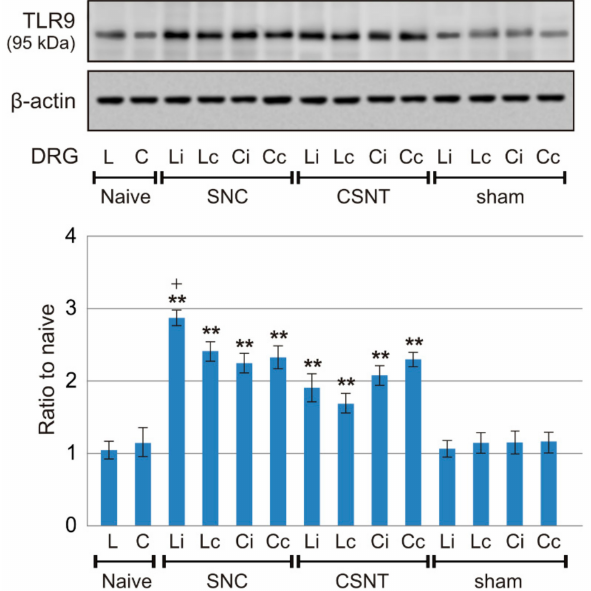
Figure 5. Results of Western blot analysis of TLR9 protein levels. TLR9 protein levels were